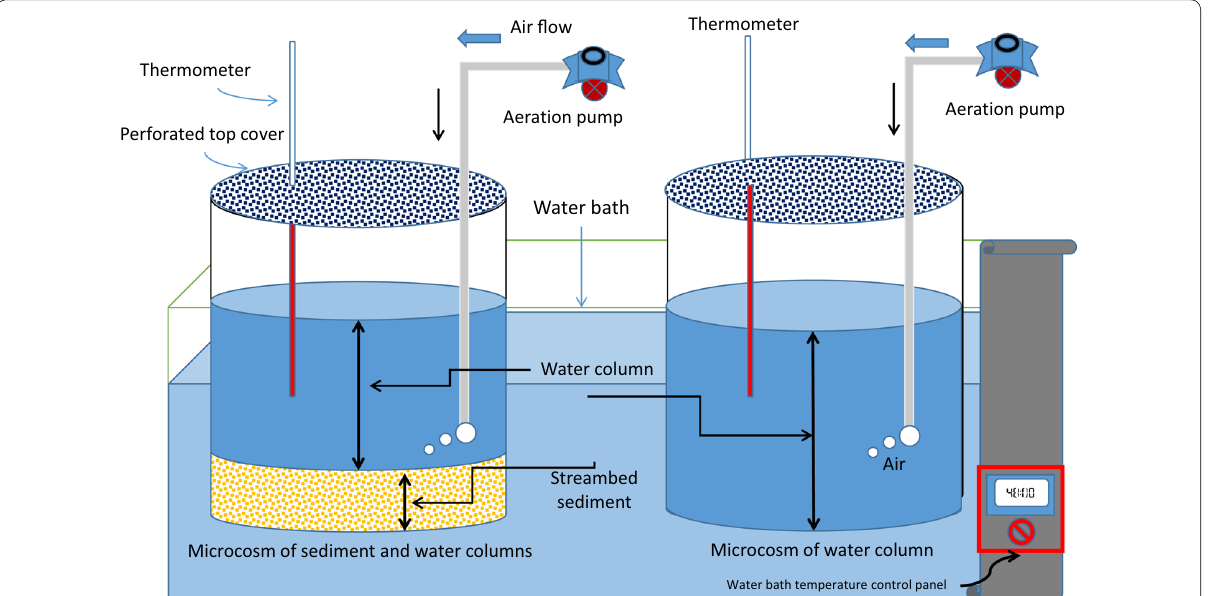
Fig. 1 Experiment sketch of microcosm study (left shows the microcosm of sediment and water column, and right shows water column